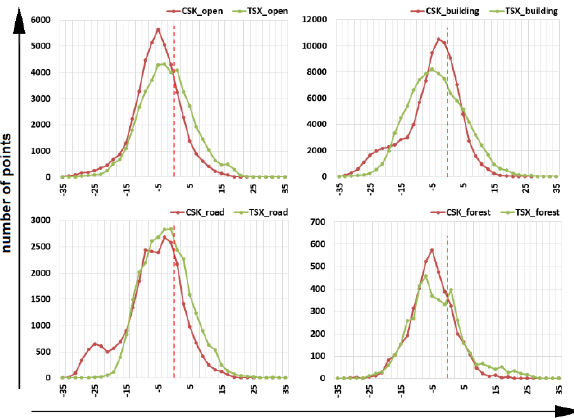
Figure 5. Distribution of ΔZ between tested and reference DSMs for each